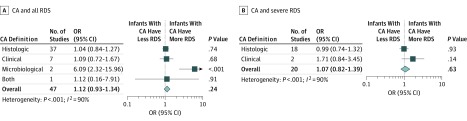
Meta-analysis of the Association Between Chorioamnionitis (CA) and Respiratory Distress Syndrome (RDS)Grouped by definition of CA and severity of RDS. OR indicates odds ratio.